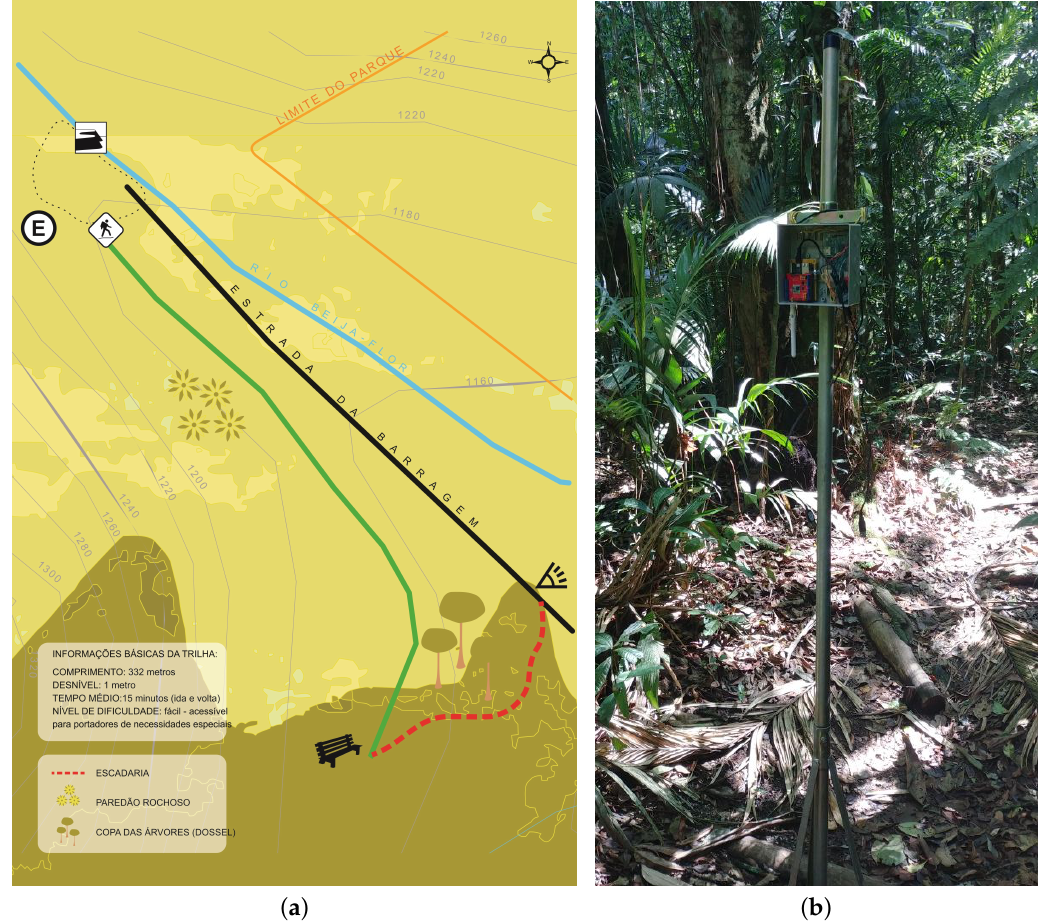
Figure 2. Measuring location map and prototypes. ( a ) Map of the site of experiments at PARNASO (https://www.icmbio.gov.br/parnaserradosorgaos/). ( b ) The pole-mounted prototype